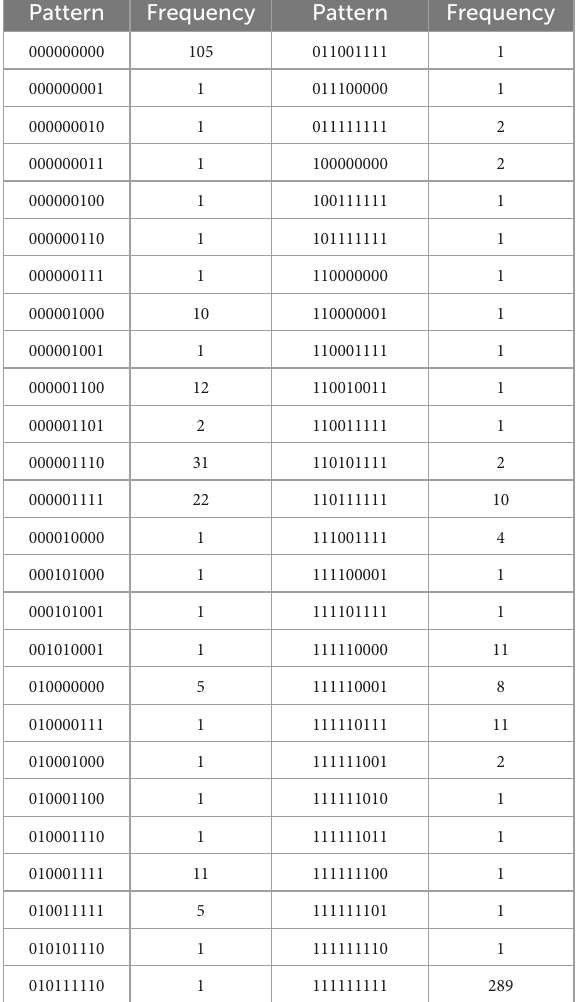
TABLE 4I For B = { i 1 ,..., i 5 , d 1 ,..., d 4 } , with N = 577, k = 9 items, and u = 52 unique response patterns ( Appendix B ).